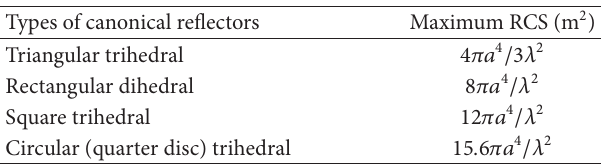
Table 1: RCSs of the most common reflectors (where a is the side length, and 𝜆 is the